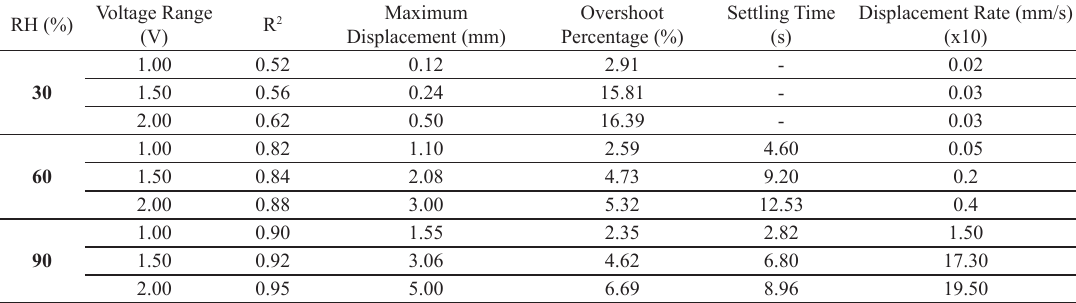
Table 1. Device performance for various operating conditions, presenting R 2 , maximum displacement, overshoot percentage, settling Time, and displacement speed as a function of voltage range and RH. Voltage Range Maximum RH (%) R 2 (V) Displacement